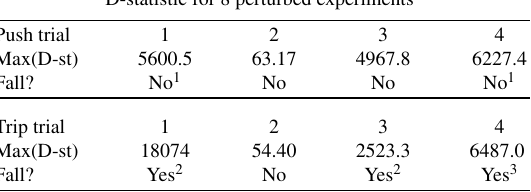
Table 3 D-statistic for 8 perturbed